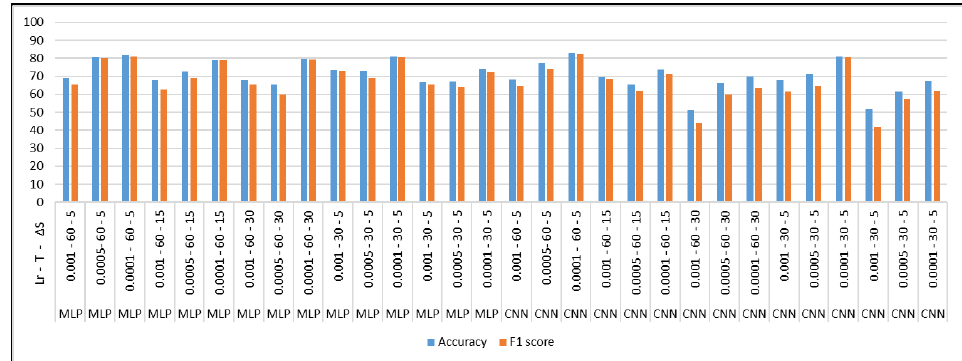
Figure A1. Selection of hyper-parameters for the feature learning approaches. lr: learning rate; T: window size; ∆ S : step